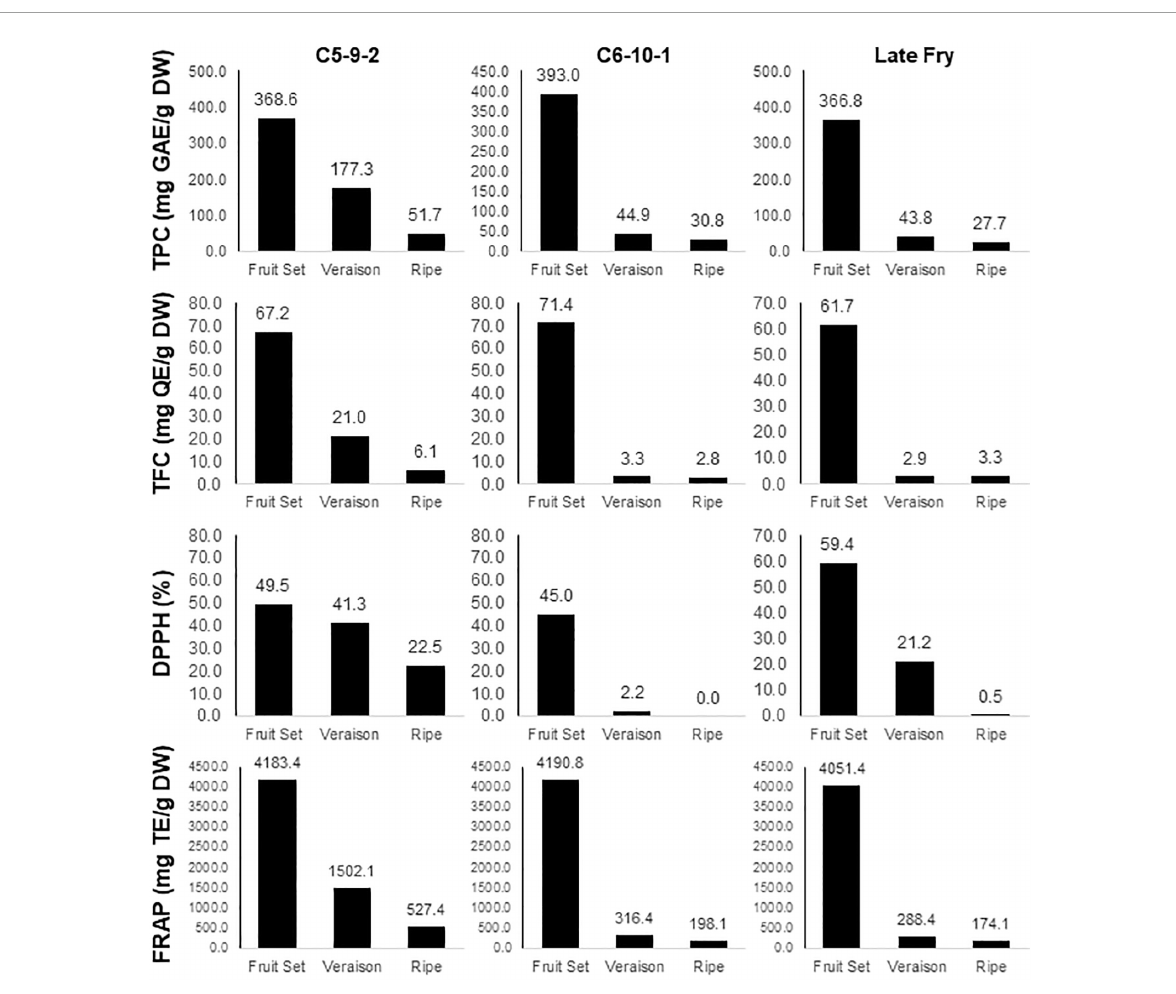
FIGURE3 Estimation of TPC, TFC, and DPPH/FRAP activities in the three muscadine genotypes during berry development. The name of the trait and unit of value is presented on the left side of the panel. The name of the genotype is presented in the top.